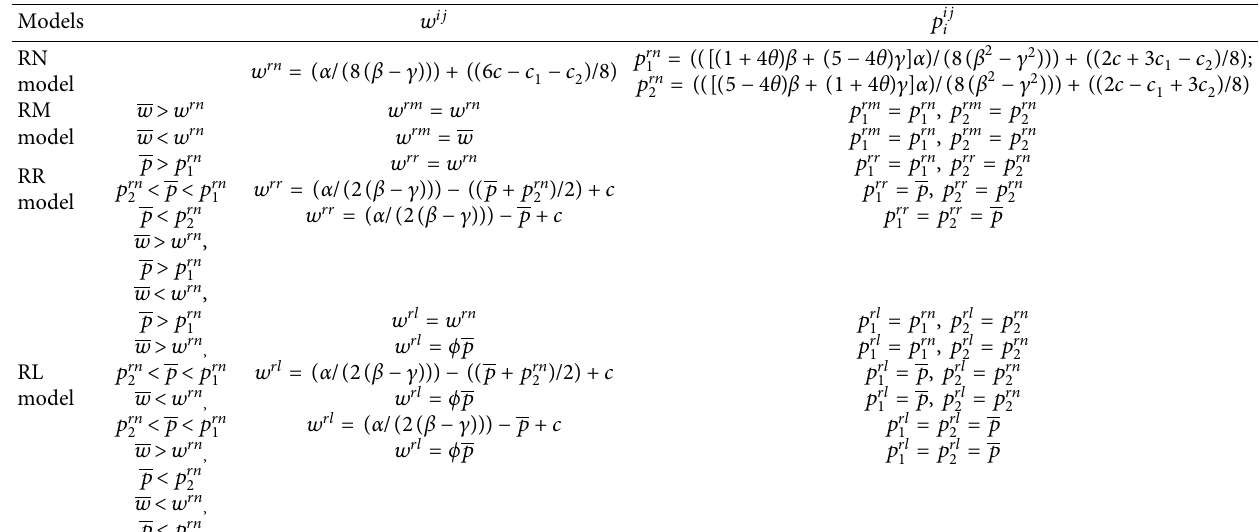
Table 2: Optimal wholesale and retail prices for the four